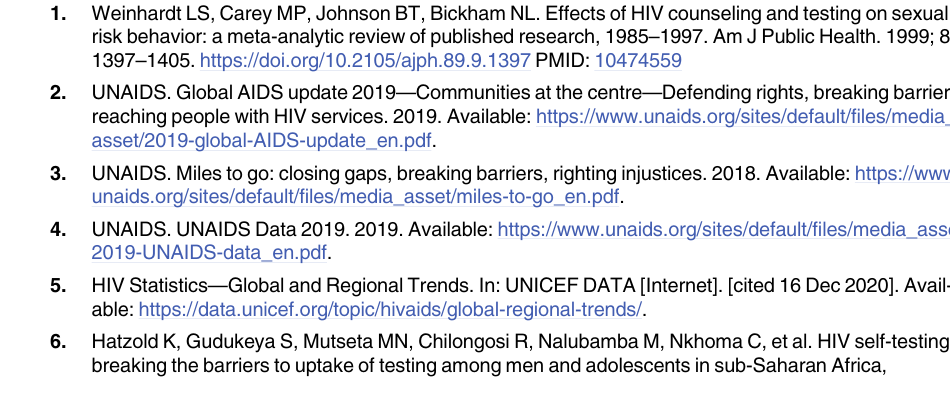
S2 Table. Implementation recommendations for campus-based HIVST distribution.